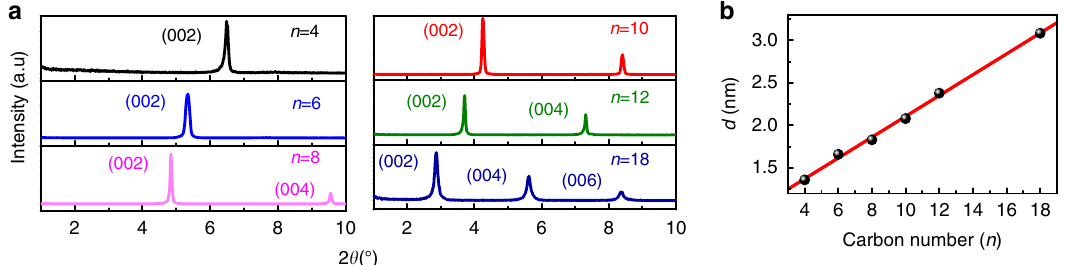
Fig. 4 The XRD results of six 2D OIHP thin fi lms. a XRD patterns. b The dependence of interlayer distance (d) on the alkyl chain length of organic cations. The interlayer distance is calculated in terms of the positions of (002) diffraction peak.